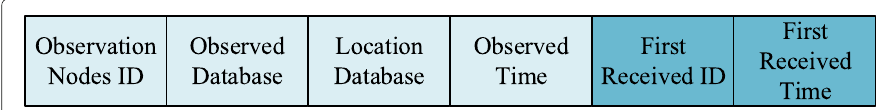
Fig. 2 Improved format of data packet